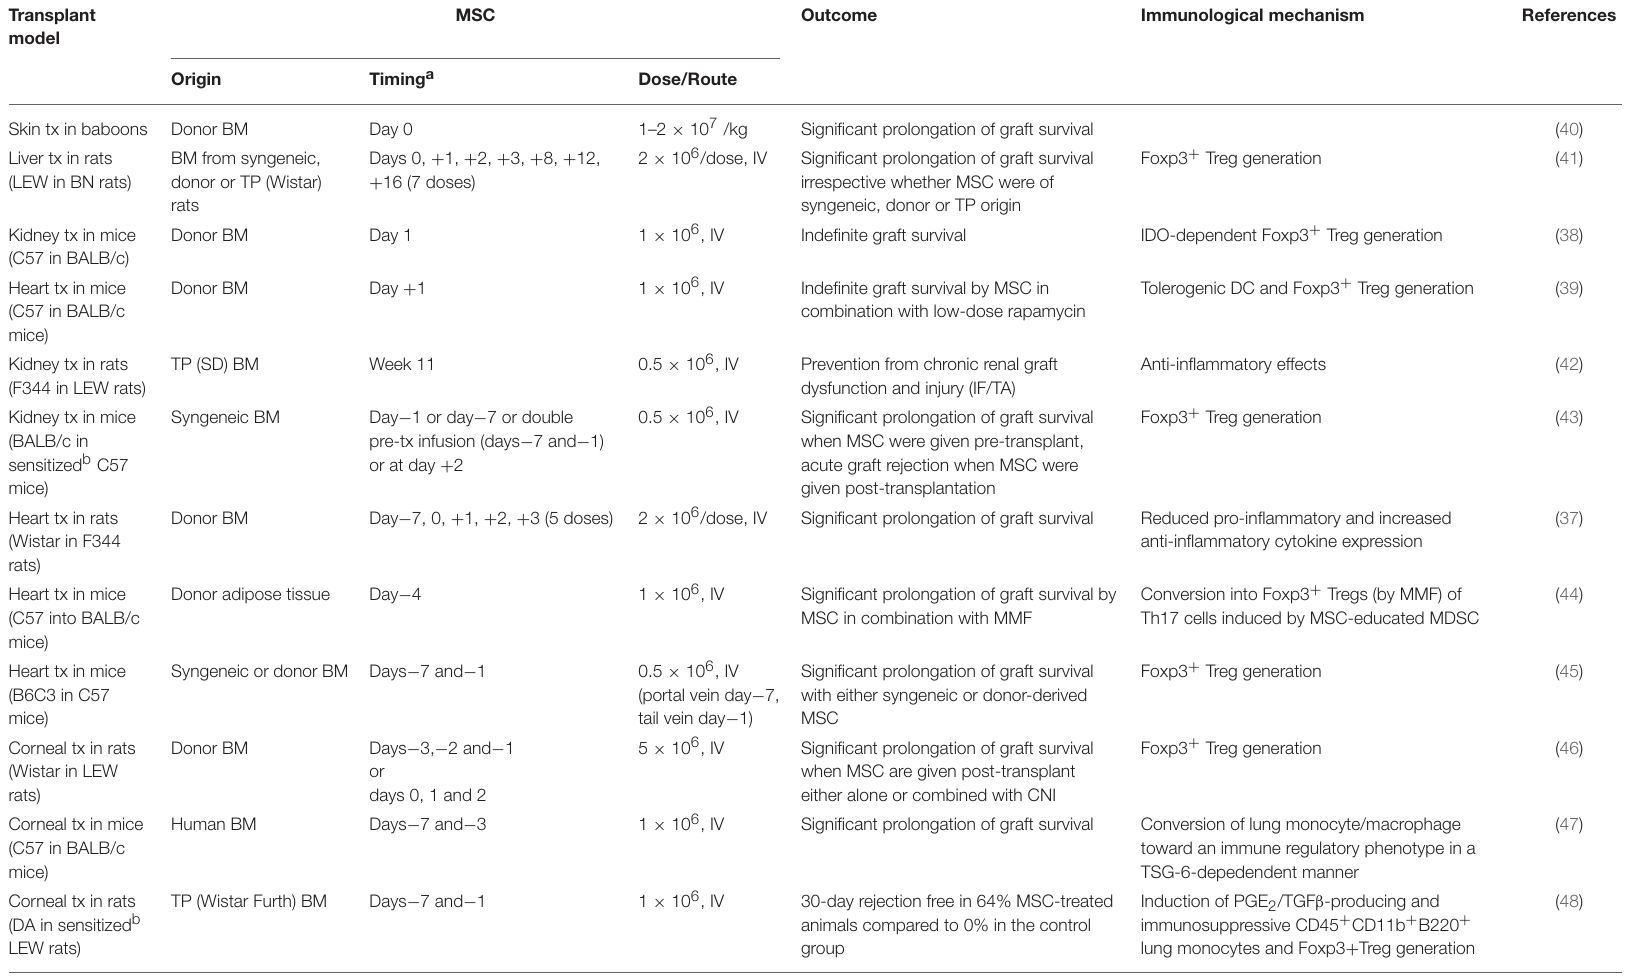
TABLE 1 | MSC in preclinical transplant